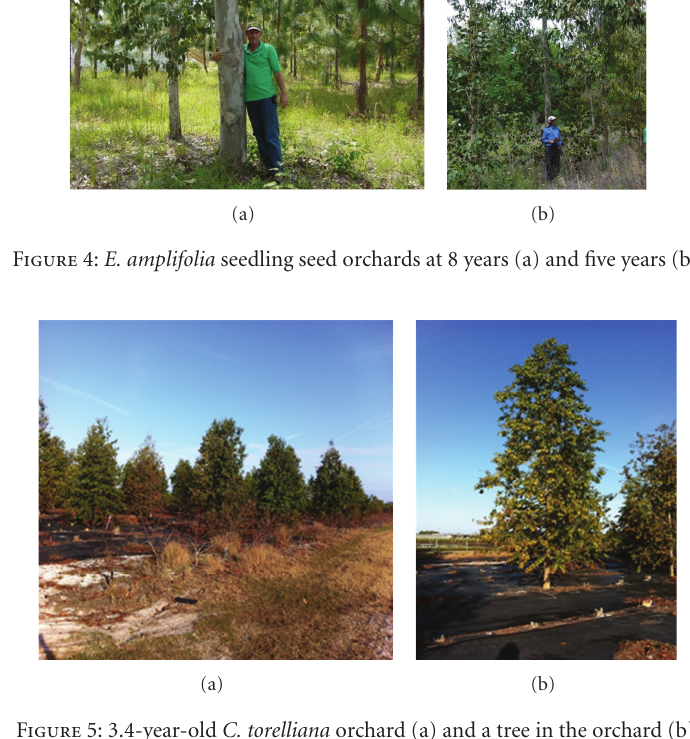
Figure 5: 3.4-year-old C. torelliana orchard (a) and a tree in the orchard